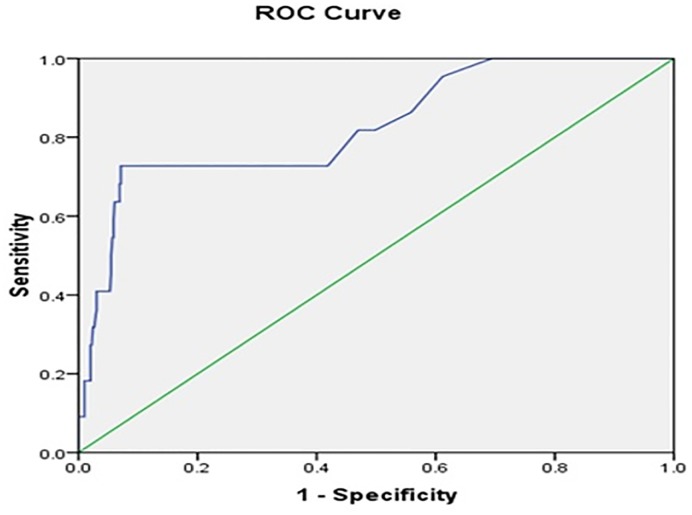
Atypical lymphocyte % more than 0.55 use as a predictive cutoff value to suspect severe dengue cases during the disease progression.(AUC = 87.2% [95%CI = 73%-93.4%]).